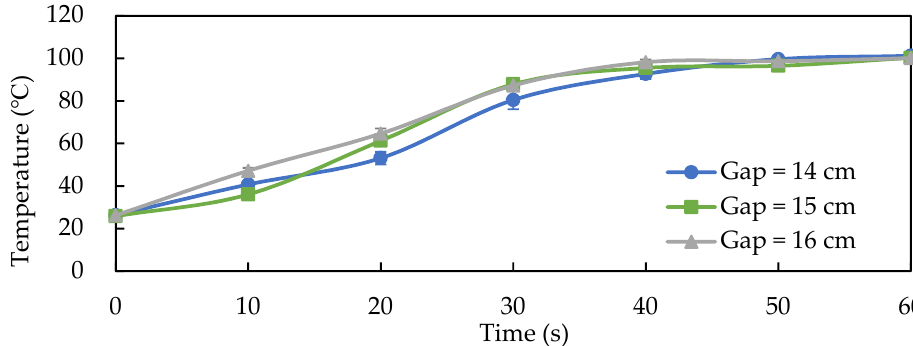
Figure 2. The temperature profile of 500 g solid-state fermented W. cocos mycelia product for different electrode gaps during RF pasteurization. Data are expressed as the mean ± SD ( n = 3).